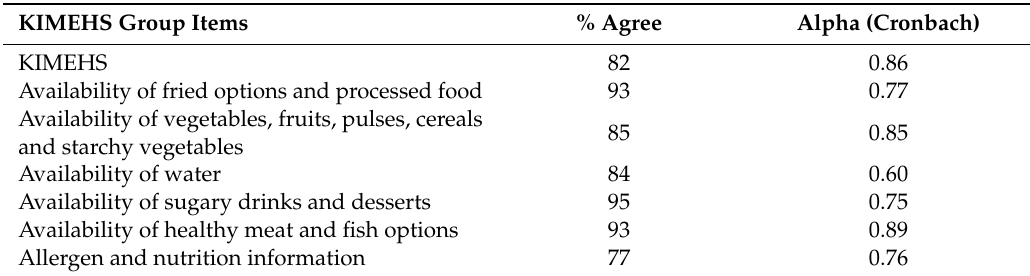
Table 2. Menu components content and reliability.